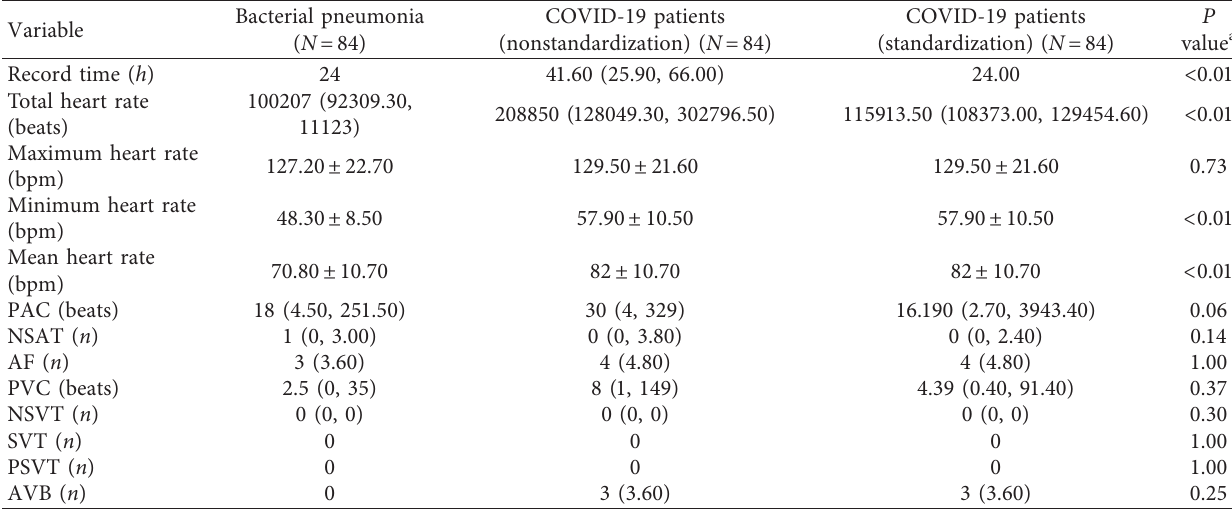
Table 2: Heart rate, arrhythmias, cardiomyocyte injury marker, and death in patients with bacterial pneumonia and COVID-19